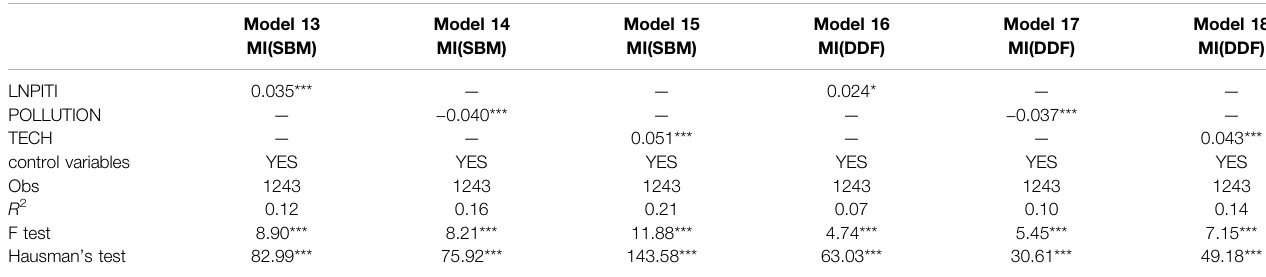
TABLE 6 | Robustness